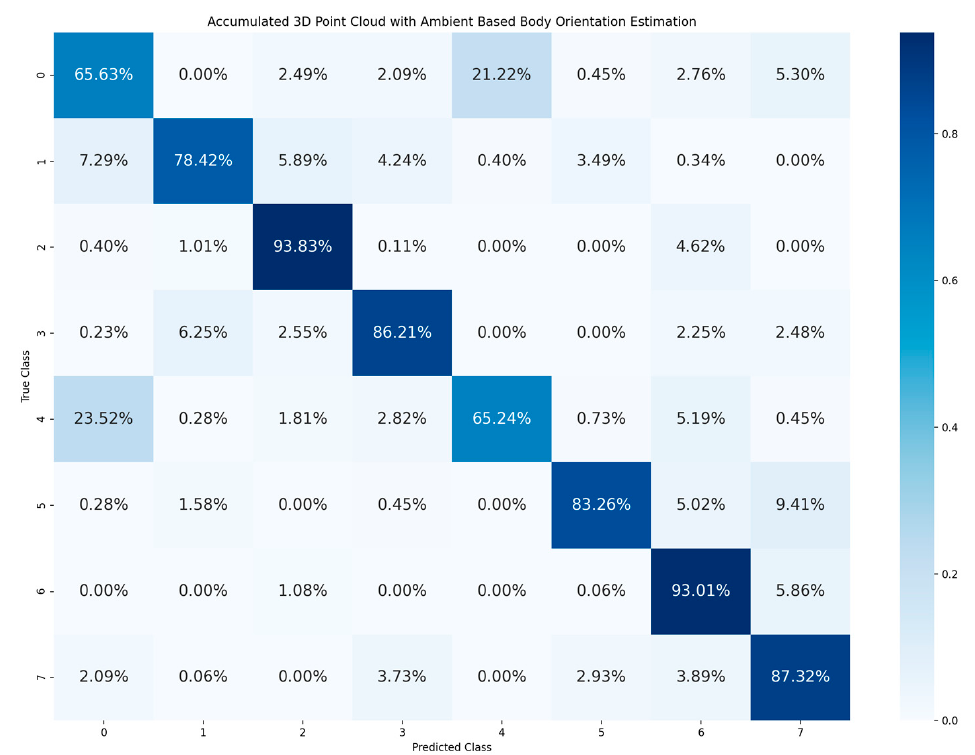
Figure 8. Confusion matrix of body orientation estimation accumulated from joined body and head orientation estimation using 3D point cloud data with ambient.